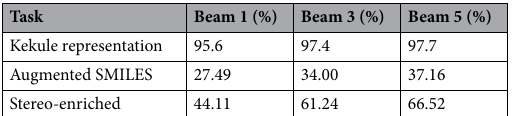
Table 3. The performance of Struct2IUPAC model for different validation